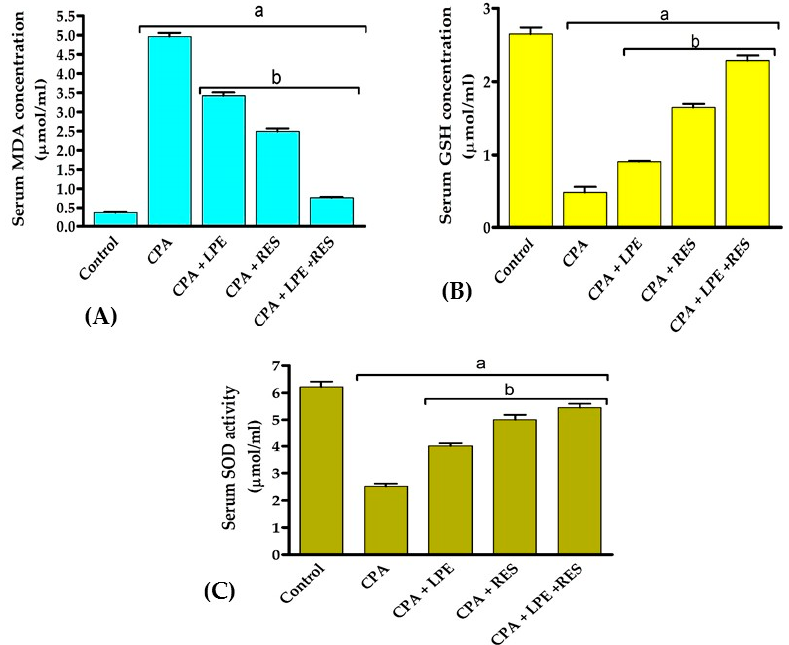
Figure 2. Effects of LPE and/or RES on the antioxidants and oxidative stress markers in cyclophosphamide-treated rats’ ovarian tissue. ( A ) The levels of MDA, ( B ) GSH, and ( C ) SOD enzyme activity. Data expressed as mean ± SEM. a p < 0.05 versus control group; b p < 0.05 versus a CPA group, (n = 7). CPA: Cyclophosphamide, LPE: Lemon peel extract, RES: resveratrol. 2.3. Effects of LPE and RES on Ovarian Tissue Inflammation Markers in Cyclophosphamide- Treated Rats TNF- α , NF-KB, and COX-2 levels in CPA rats have been substantially ( p < 0.05) higher than in normal control rats, as shown in Figure 3. After treating with LPE and RES, the values were considerably ( p < 0.05) lower in all further groups. Furthermore, the ovar- ian levels of TNF- α , NF-KB, and COX-2 were also effectively decreased ( p < 0.05) in rats cured by LPE + RES compared to untreated CPA rats. From these data, we discovered that co-treatment of both LPE with RES in CPA-treated rats minimized the inflammation caused by CPA treatment.